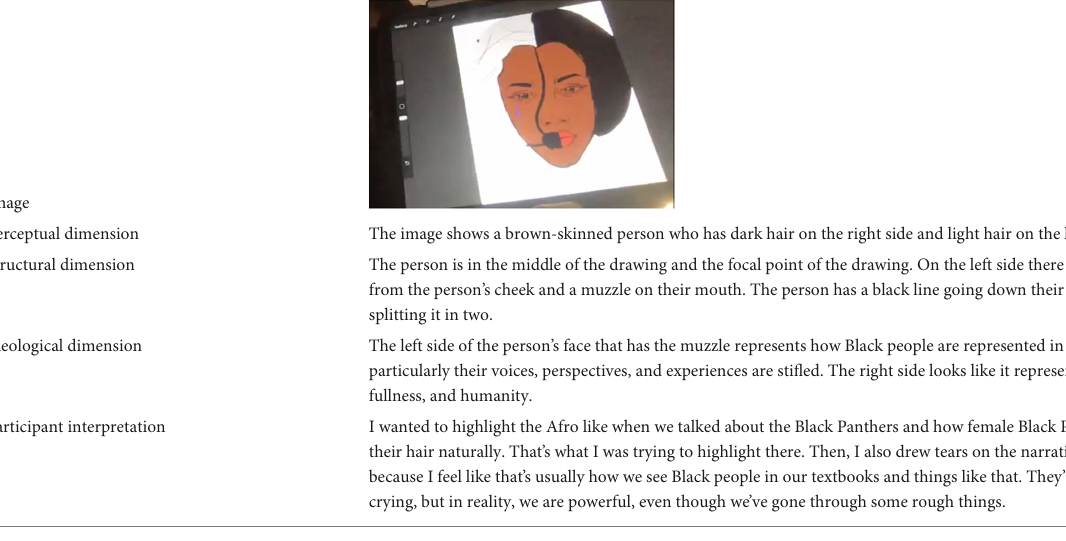
woman with an Afro with a tear streaming down her face ( Figure 1 ). Mackenzie shared her artwork at the Community Arts Showcase,